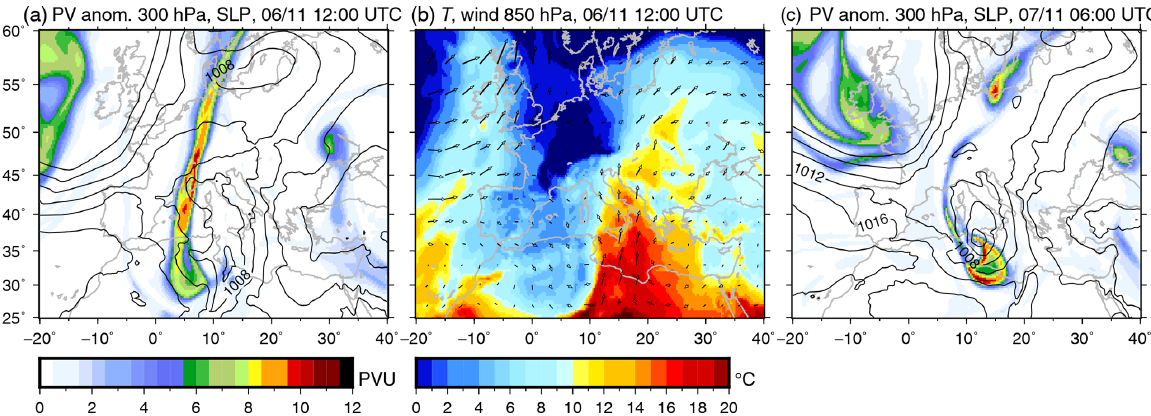
Figure 1. Potential vorticity (PV) anomaly at 300hPa (colour scale) and SLP (isocontours every 4hPa) at 12:00UTC on 6 November (a) and 06:00UTC on 7 November (c) ; temperature (colour scale, ◦ C) and wind at 850hPa at 06:00UTC on 6 November (b) from the ERA5